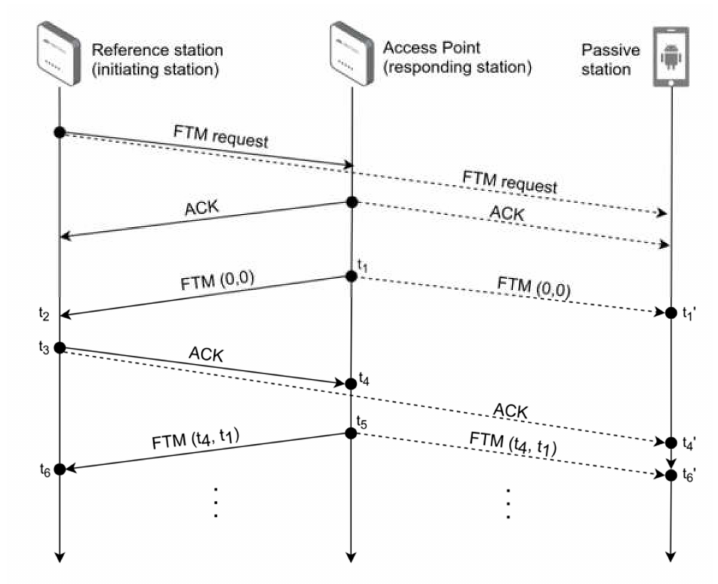
Figure 2. Basic procedure to gather the time-di ff erence of arrival (TDOA) measurements in the passive station, according to the proposed WiFi passive TDOA